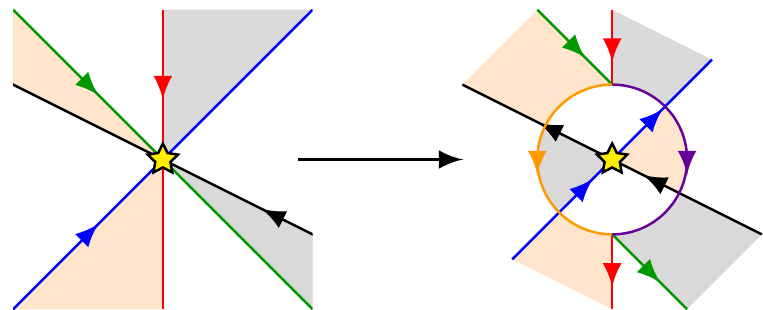
Figure 8. Deconfinement in the case of four NS5 brane intersecting on top of an orientifold point. Recombining two NS5s branes so that they avoid the intersection gives us a Lagrangian theory in the same universality class as the original theory. In this case we have kept two branes intersecting over the orientifold fixed point, leading to an antisymmetric chiral multiplet. It is possible to deconfine this multiplet if desired. [Figure reproduced from [18] with